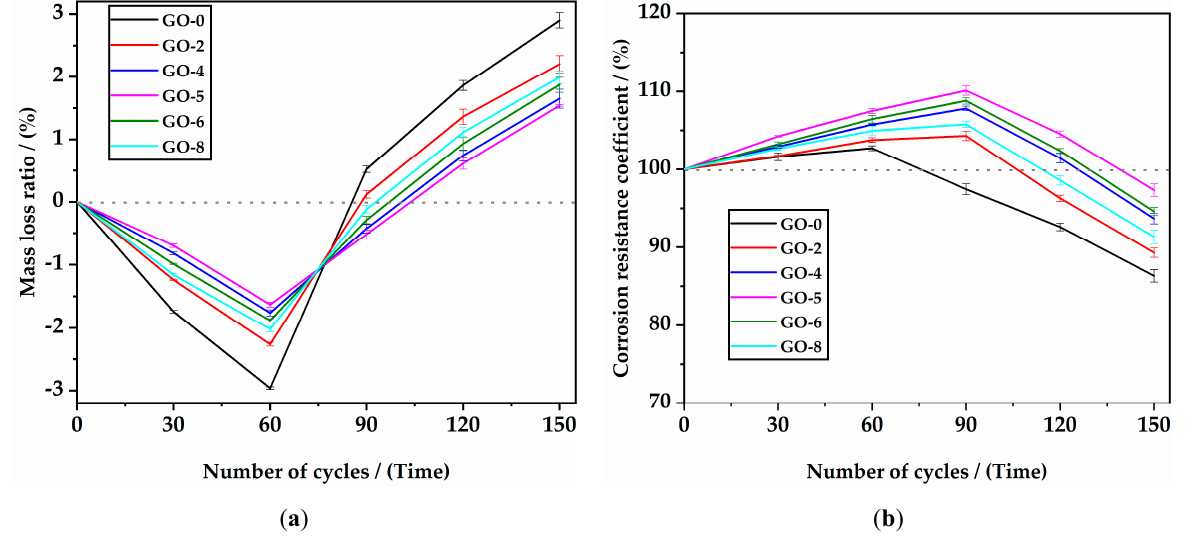
Figure 12. Sulfate a tt ack resistance results of HSLWC with di ff erent GO incorporation contents: ( a ) mass loss ratio; ( b ) corrosion resistance coe ffi cient.